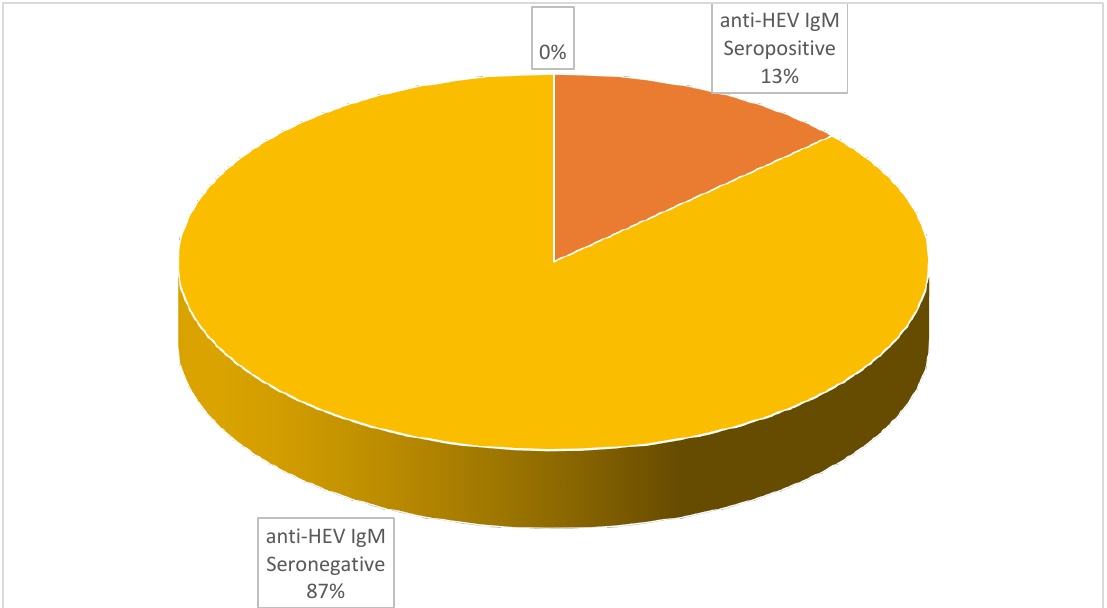
Figure 1. Seroprevalence of hepatitis E virus IgM antibodies among pregnant